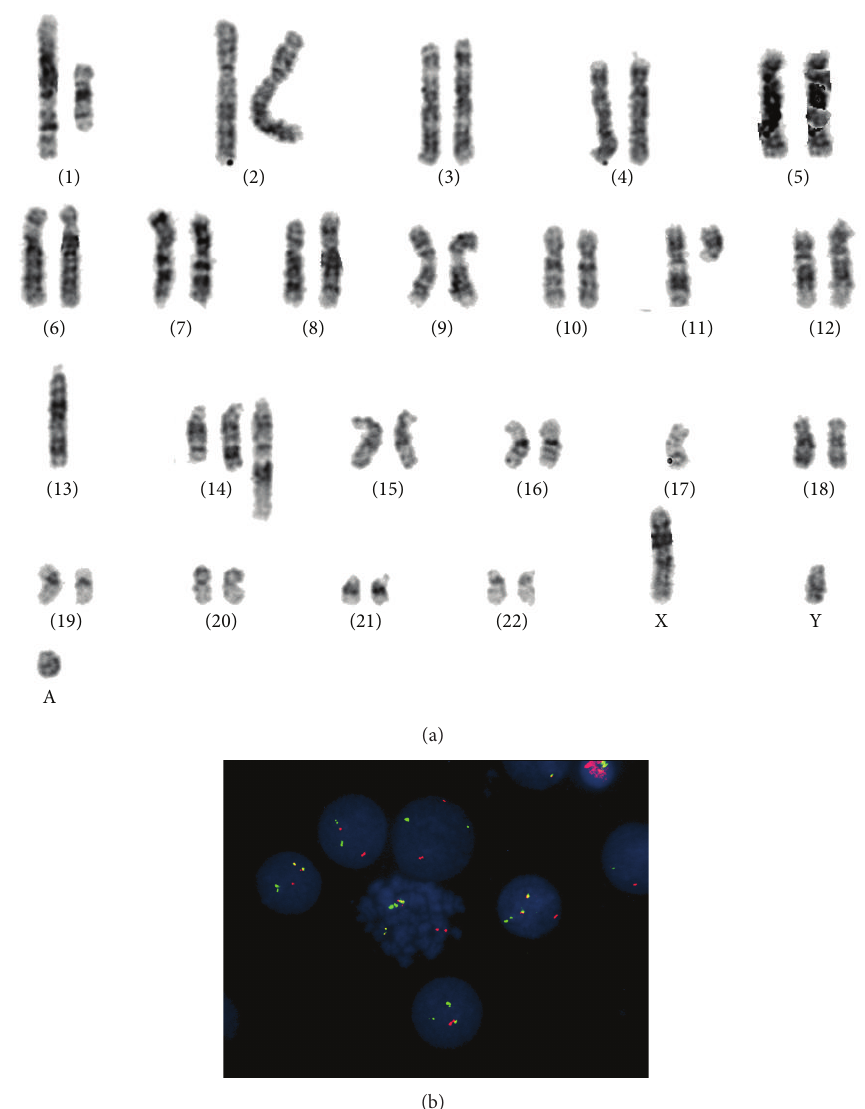
Figure 4: (a) Karyotypic analysis showing complex chromosomal abnormalities including translocation t(11;14). (b) FISH using IGH-CCND dual color dual fusion on interphases and metaphases cells showed the presence of the translocation